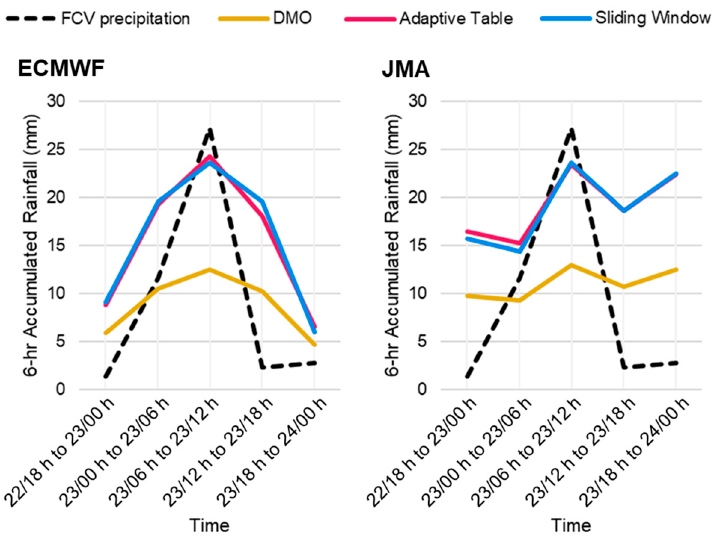
Figure 17. T + 12 6 h FCV rainfall (as the observed truth), the DMO rainfall of ECMWF/JMA and those with frequency-matching methods applied, for 22–24 June 2015.